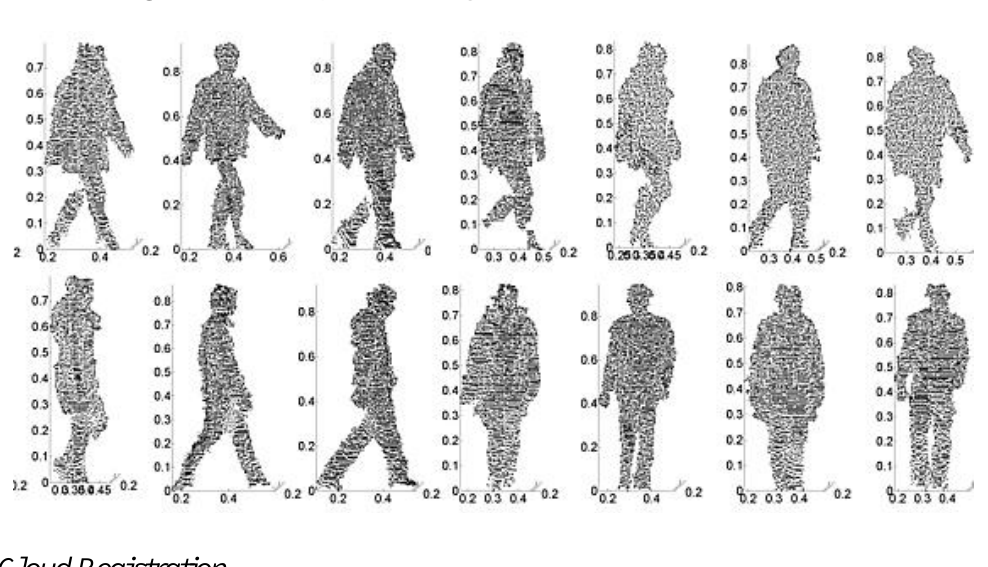
Figure 13. 2.5D point cloud gait features with different views.